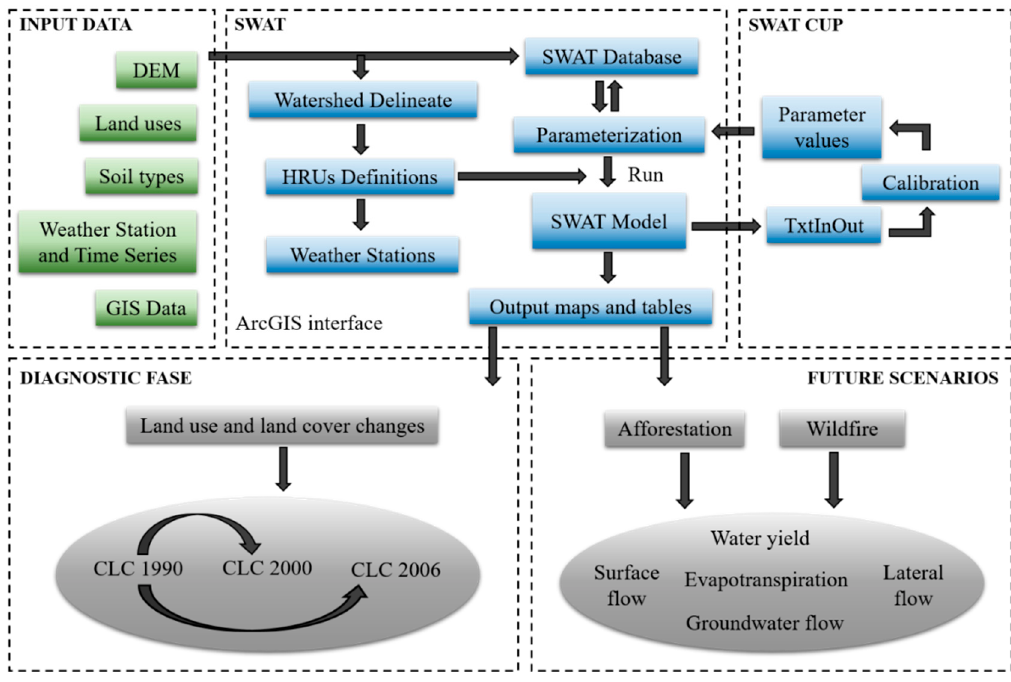
Figure 5. The conceptual framework model for constructing and modelling the water resources in the SWAT (Soil and Water Assessment Tool).